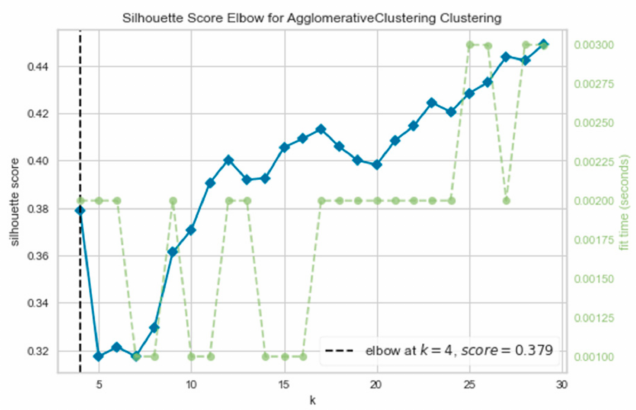
Figure 10. Silhouette score graph for the proposed PCA-Ward while k =